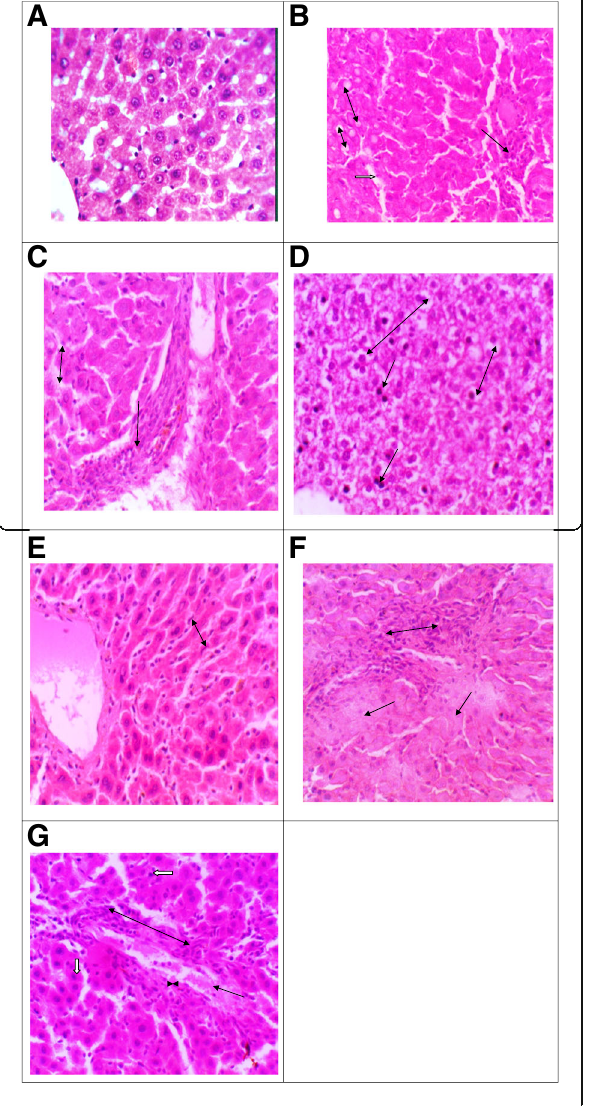
Fig. 1 a Photomicrograph of liver section from control rat showing normal hepatic architecture with cords of hepatocytes radiating from the central vein and separated by blood sinusoids (H&E ×400). b Photomicrograph of liver section from treated rat of low dose revealing vacuolar changes (arrow with two heads), inflammatory cells (black arrow), and distended sinusoidal space (white arrow) (H&E ×400). c Photomicrograph of liver section from treated rat of high dose showing increased inflammatory infiltration (black arrow) and distended sinusoidal space (arrow with two heads) (H&E ×400). d Photomicrograph of liver section from treated rat of high dose showing pyknotic nuclei (black arrow) and swelled vacuolized hepatocyte (black arrow with two heads). e Photomicrograph of liver section from treated rat of high dose showing an increase in Kupffer cells (black arrow with two heads) (H&E ×400). f Photomicrograph of liver section from treated rat of high dose showing eosinophilic material (black arrow), infiltration of inflammatory cells (black arrow with two heads), and distorted hepatic architecture (H&E ×400). g Photomicrograph of liver section from treated rat of high dose showing distorted hepatic architecture, pyknotic nuclei (white arrow), hyaline material (black arrow), and inflammatory cells (black arrow with heads) (H&E